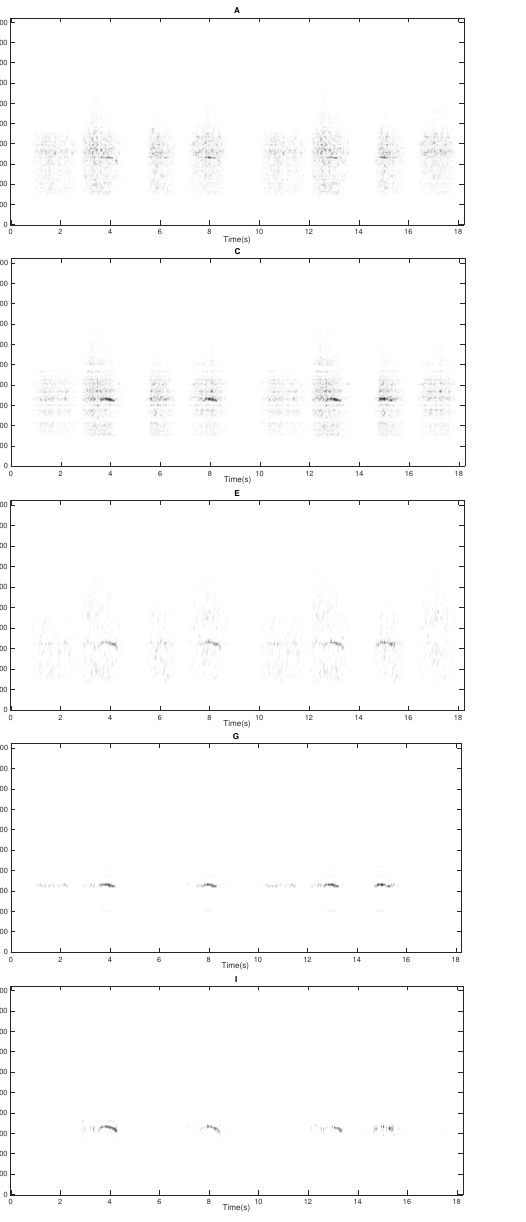
Figure 10. The estimated wheezing spectrogram ˆ X W obtained from the input spectrogram X shown in Figure 1 for the different methods evaluated. ( A ) NMF, ( B ) SNMF, ( C ) SSNMF, ( D ) 2S-NMPCF, ( E ) 1S-NMPCF, ( F ) T-NMPCF, ( G ) CNMF, ( H ) ST-NMPCF, ( I ) IIS 0 -NMPCF and ( J )